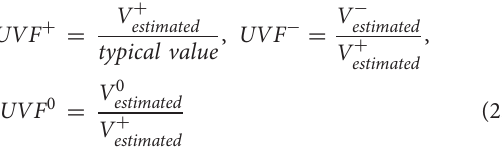
continuously through the state variable structure filters